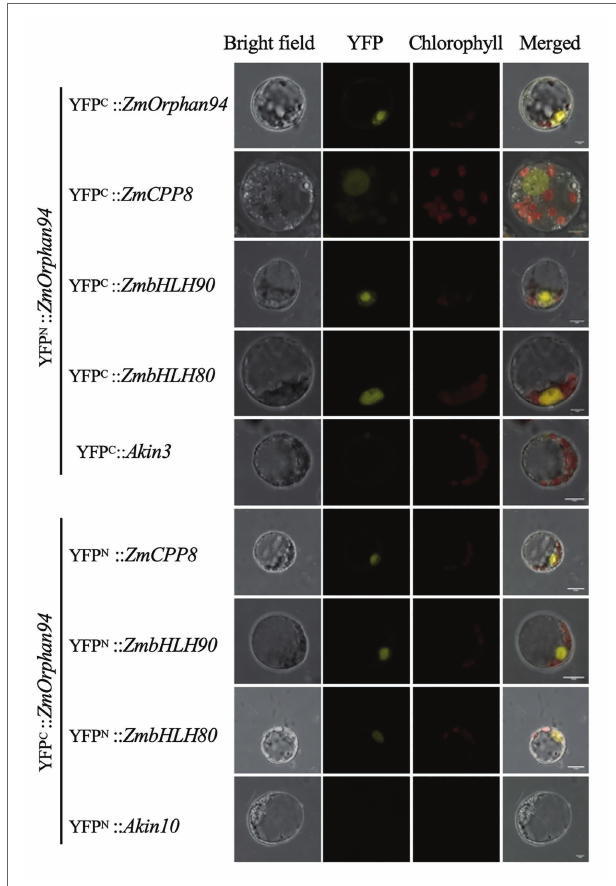
FIGURE 2 | Bimolecular fluorescence complementation (BiFC) analysis of protein-protein interactions between OsOrphan94 and other TF binding to ZmPEPC1 upstream region. Pairs of proteins fused to complementary yellow fluorescent protein (YFP) halves were transiently expressed in etiolated maize mesophyll protoplasts. BiFC fluorescence is indicated as the YFP signal. Maize mesophyll protoplasts co-transformed with YFP C :: Akin3 and YFP N :: ZmOrphan94 , and YFP N :: Akin10 with YFP C :: ZmOrphan94 were used as negative controls. Scale bars = 10 μ